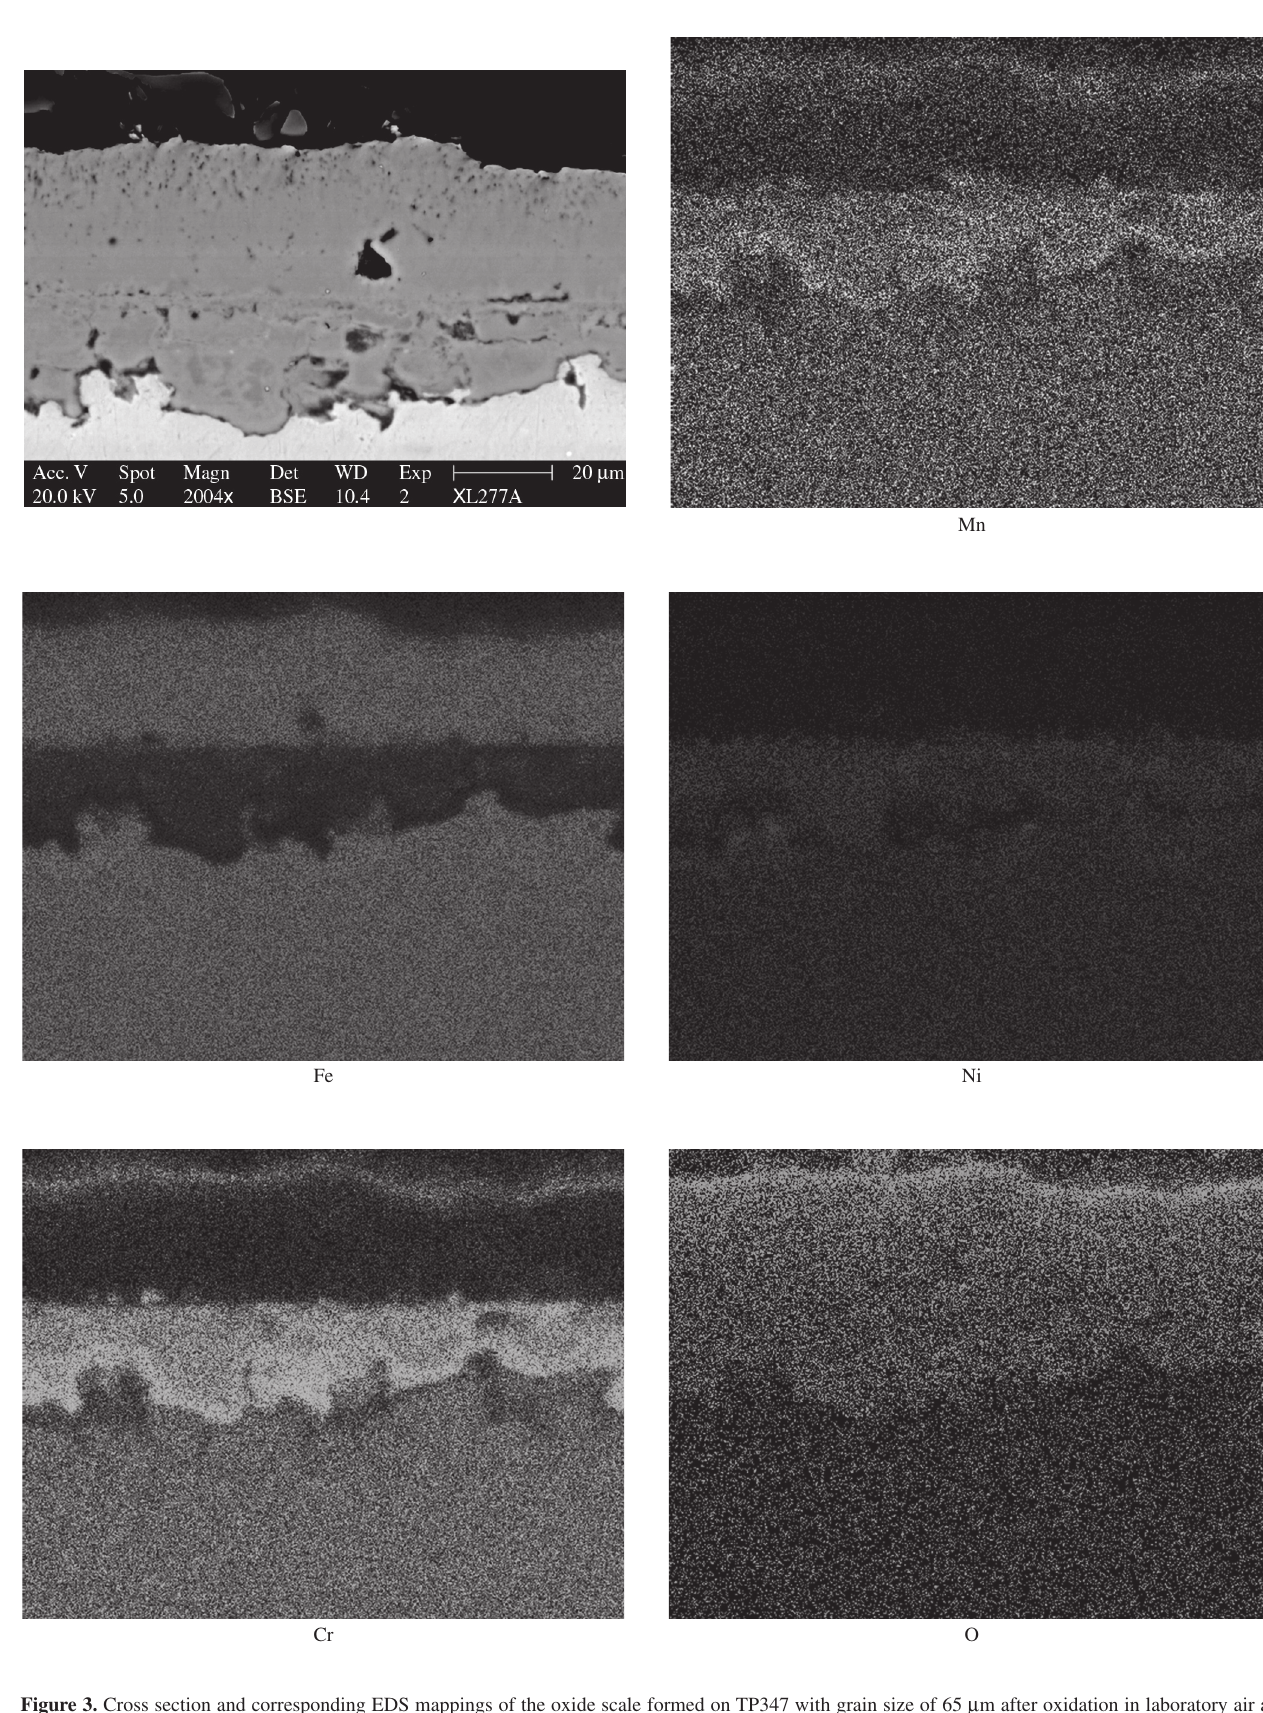
Figure 3. Cross section and corresponding EDS mappings of the oxide scale formed on TP347 with grain size of 65 µ m after oxidation in laboratory air at 750 °C for 120